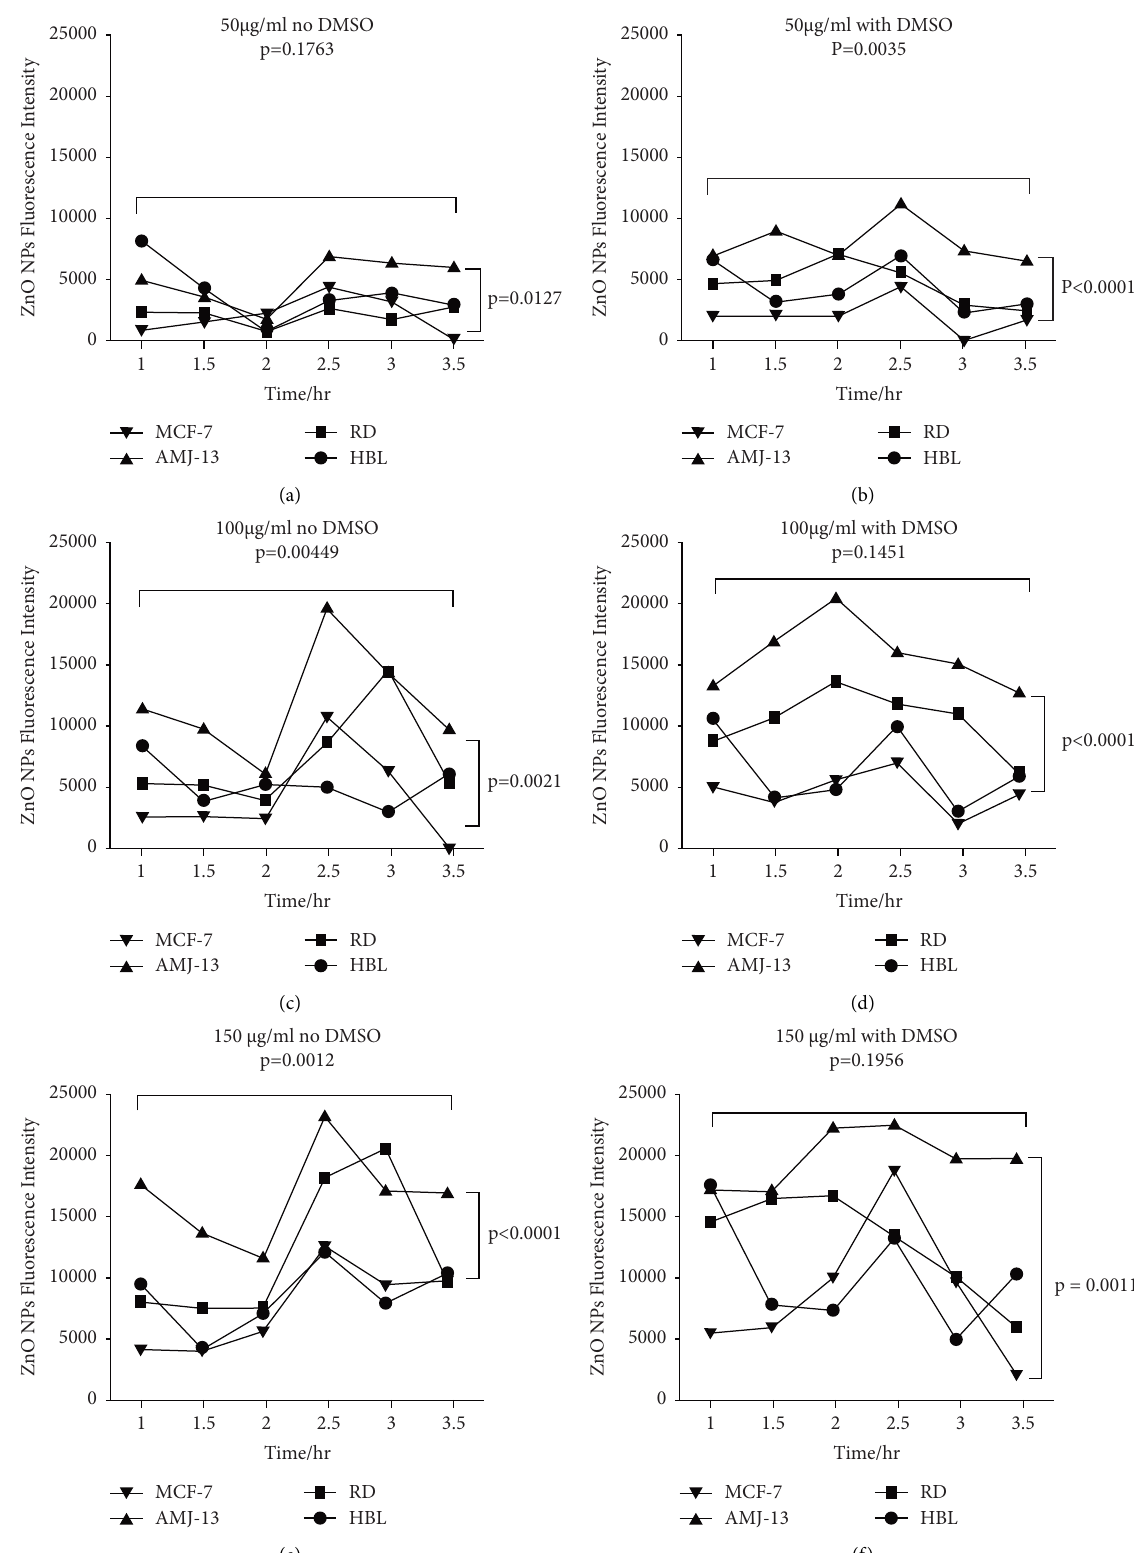
Figure 5: Intensity of ZnO NPs